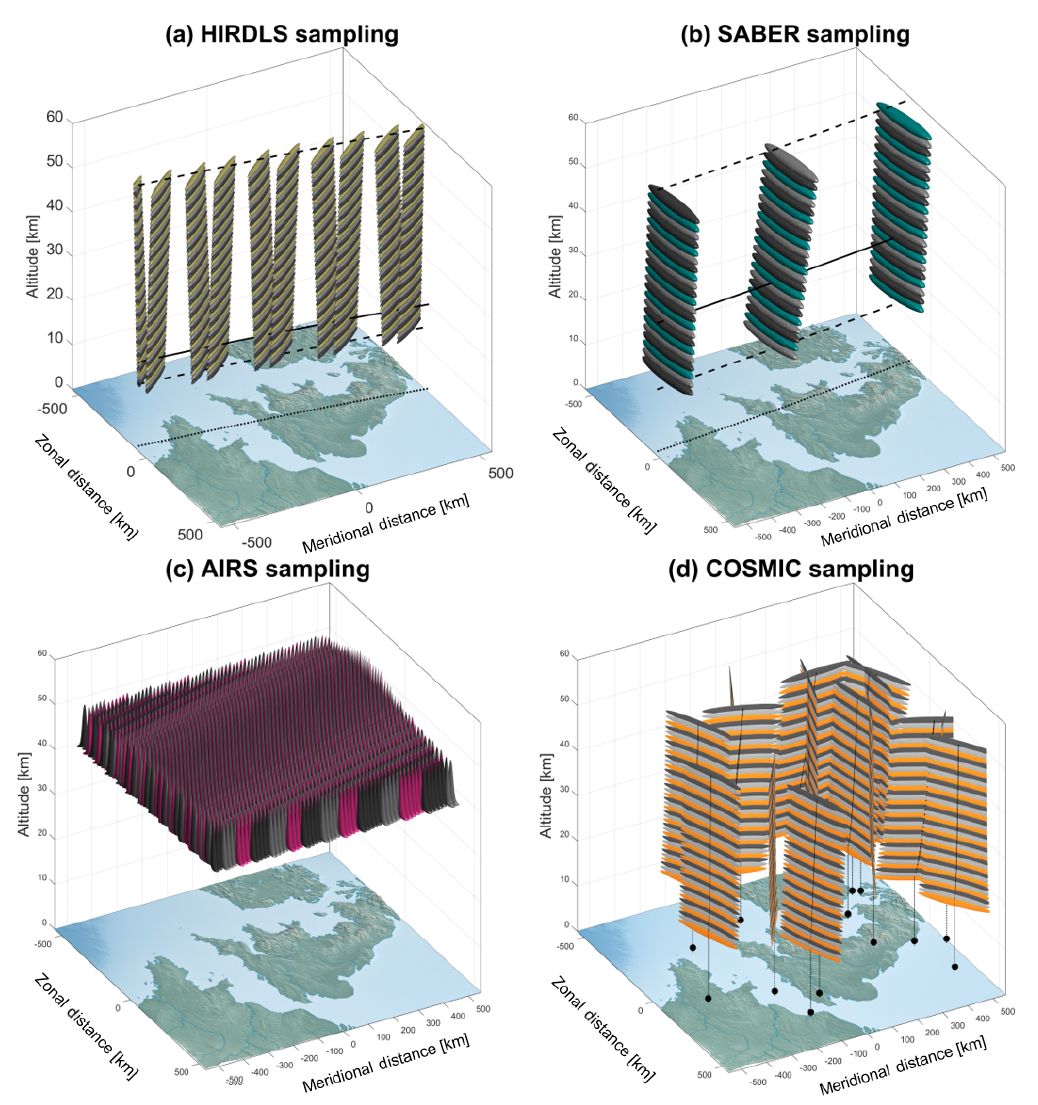
Figure 1. Approximate averaging volumes for (a) HIRDLS, (b) SABER, (c) AIRS-L1 and (d) COSMIC, shown over northwestern Europe for scale. Solid volumes show the regions which contribute the largest 99% of the signal for each measurement. For (a) and (b) , solid lines show the scan track at the reference altitude for that instrument (20km for HIRDLS, 30km for SABER), dashed lines show the track at 15 and 60km in altitude, and dotted lines show the track at 0km in altitude. For (d) , black lines indicate the centre of measurement volume for each profile at each height, black circles indicate the surface geographic location corresponding to the profile centre at 15km in altitude, and a continuation of the main line joins these. Alternating colours are used for contrast between individual averaging volumes and do not indicate any technical